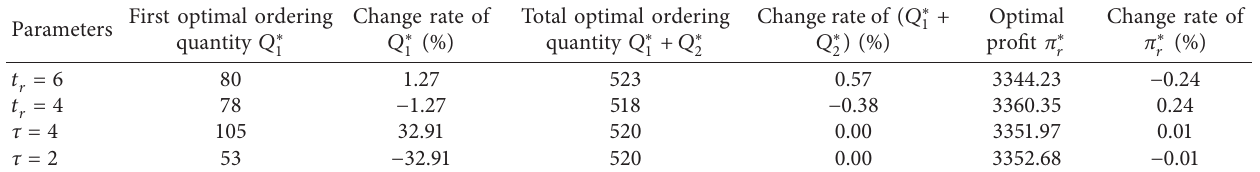
Table 5: Influence of lead time and second ordering arrival time with RFID.